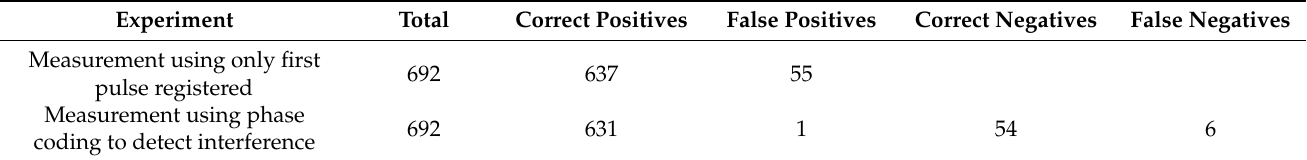
Table 1. Experiment results with two interference devices.